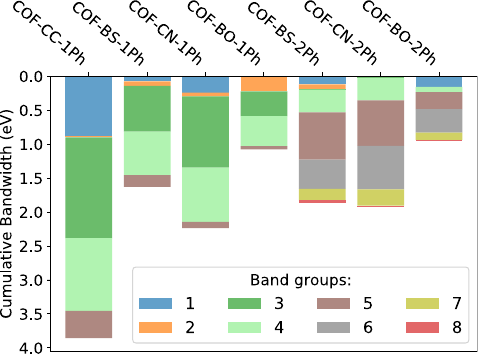
Figure 6. Electronic bandwidths for planar structures. Colors represent different groups of bands as highlighted in Fig. 5 for COF-BS-1Ph. The overall size of the bars indicate the cumulative bandwidth. Values are provided in Tables SI-1 and